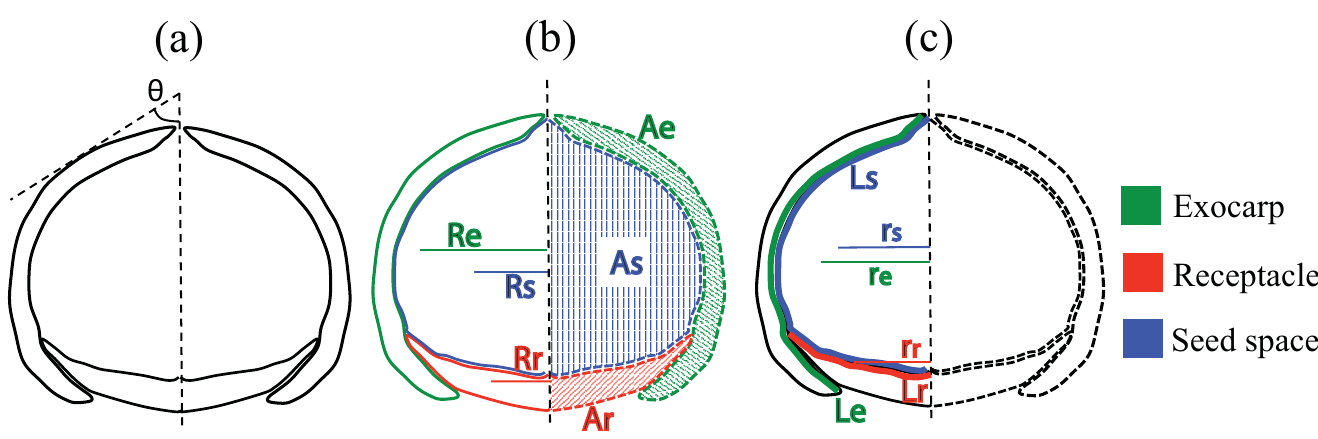
Fig 2. Exocarp rotation dimension and twelve morphological parameters. (a) The rotation angle of exocarp ( θ in degree) is directly measured. (b) Parameters for estimating the volume dimension of three parts (‘e’ for exocarp, ‘r’ for receptacle and ‘s’ for seed space): A e , A r , and A s are the area of the three parts on the left side of the longitudinal section; and R e , R r , and R s are the distance between the rotation axis and the centroid of A e , A r and A s respectively. (c) Parameters for estimating the coverage and surface area dimension of three parts (‘e’ for exocarp, ‘r’ for receptacle and ‘s’ for seed space): L s , L e , and L r are length of seed space and the internal lengths of exocarp and receptacle respectively; and r s , r e , and r r are the distance traveled by the centroid of L s , L e , and L r respectively.